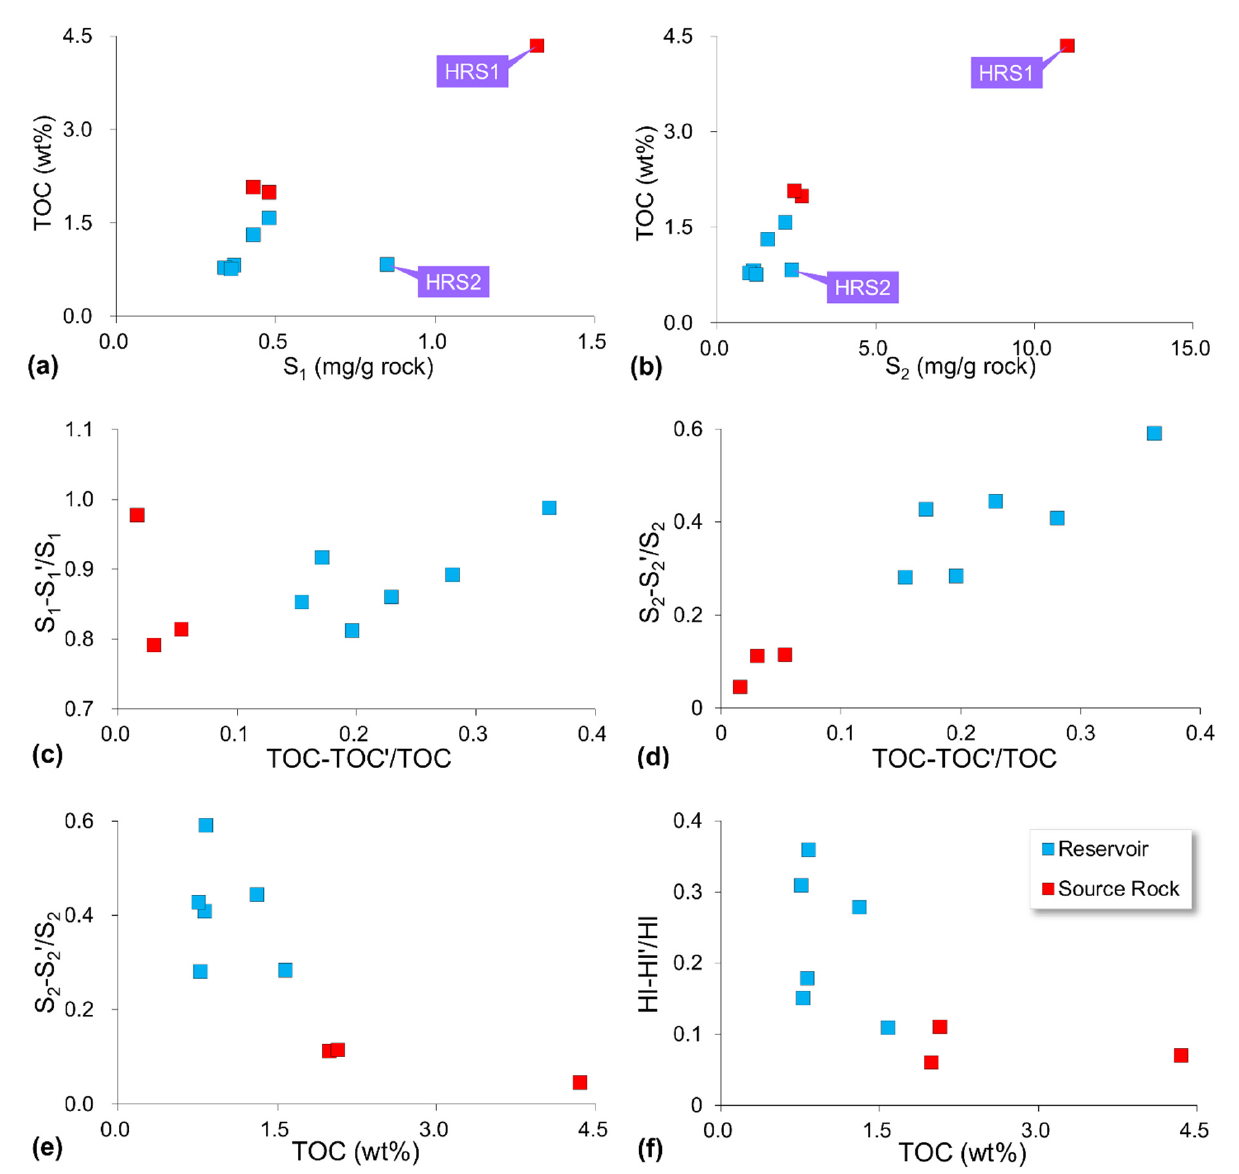
Figure 3. Correlation between S 1 ( a ) and S 2 ( b ) peak values with TOC contents. Change in S 1 , S 2 , HI and TOC contents in samples before and after solvent extraction. ( c ) Correlation between (S 1 –S 1 (cid:48) )/S 1 vs. (TOC–TOC’)/TOC; and ( d ) correlation between (S 2 –S 2 (cid:48) )/S 2 vs. (TOC–TOC’)/TOC. Correlation between (S 2 –S 2 (cid:48) )/S 2 vs. TOC contents ( e ) and HI-HI’/HI vs. TOC contents ( f